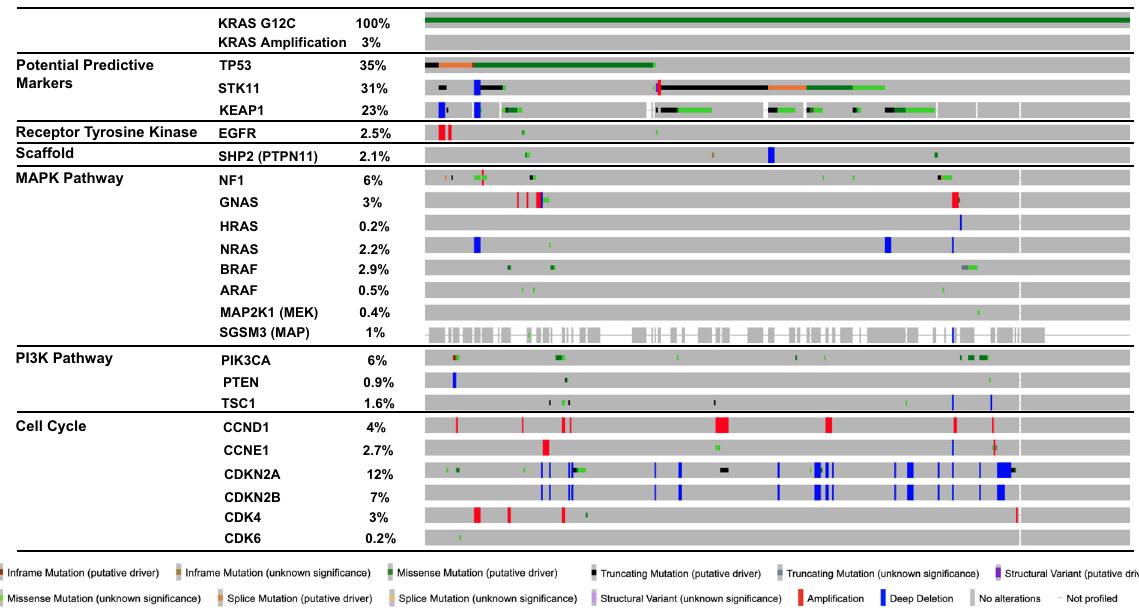
Fig. 3 Landscape of co-alterations with KRAS G12C in Non-small Cell Lung Cancer. Co-occurring genomic alterations found in KRAS G12C mutant NSCLC patients ( n = 560, cBioPortal.org) including those that have combinatorial strategies planned in clinical trials 25,26